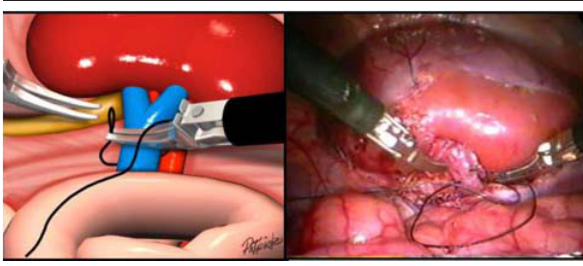
FIGURE 2 - The right hand grasper goes behind the suture that is pulled and then ending the first loop.